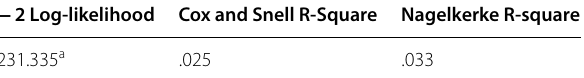
Table B: Model summary for innovation culture